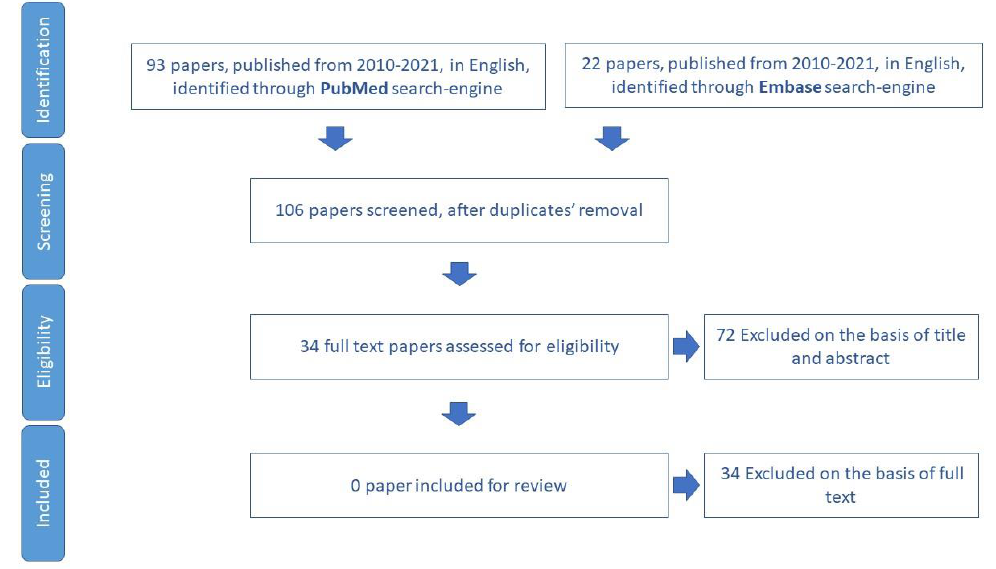
Figure 5. Process of study selection for assessment of adherence to medical visits.